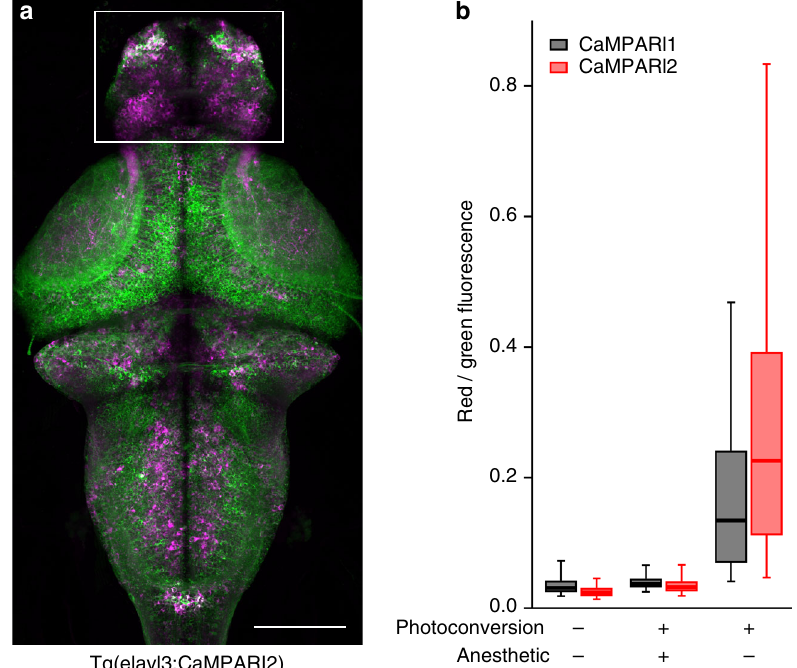
Fig. 3 In vivo characterization of CaMPARI2 in zebra fi sh. a Representative z -projection from a confocal stack from a 6-dpf larval transgenic pan-neuronal CaMPARI2 zebra fi sh brain photoconverted for 30 s during free swimming. b Boxplots represent the distribution of red-to-green fl uorescence signals from individual neurons (between 1800 and 6000 cells per condition, representing 2 – 4 fi sh (Supplementary Fig. 9, 10). Data are measured from neurons in the forebrain (white box in a ) following photoconversion of either freely swimming or tricaine-anesthetized larval zebra fi sh. Box represents 1st, 2nd, and 3rd quartile, while whiskers represent the 5th and 95th percentile. Scale bar is 100 µ